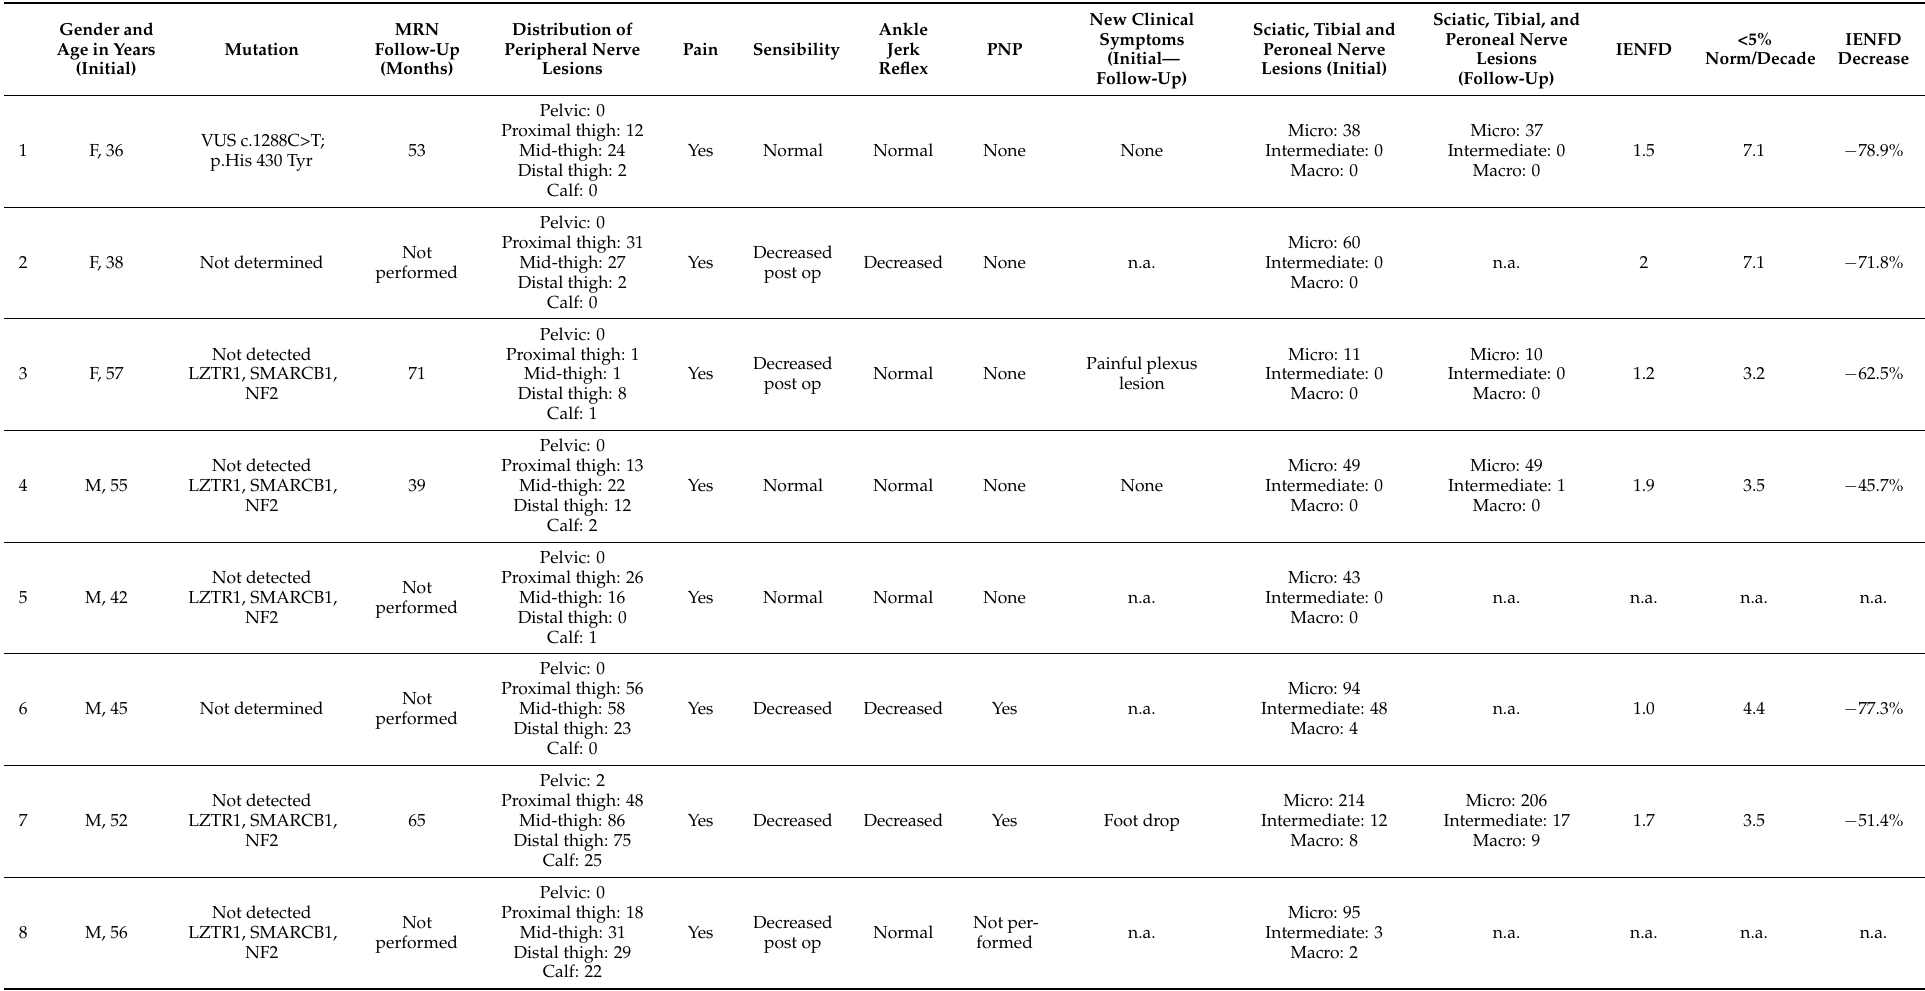
Table 1. Patient demographics and clinical